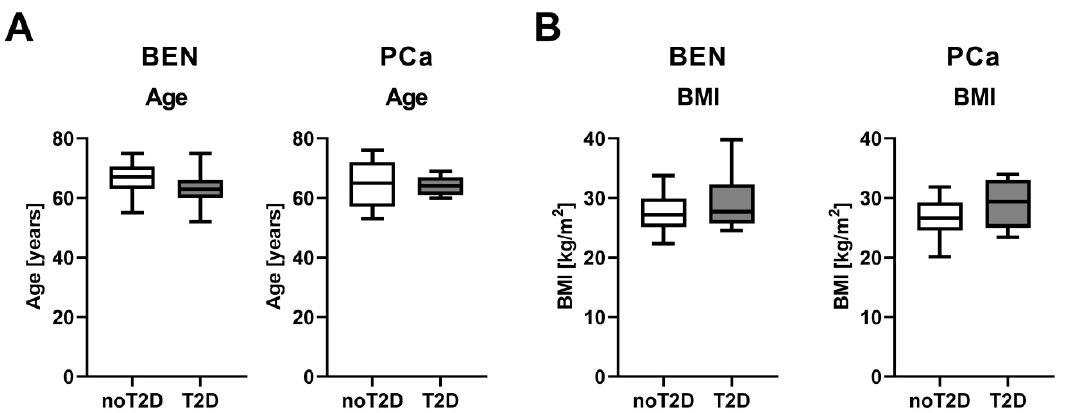
Figure 1. Benign prostate (BEN) (n = 17–17) and prostate cancer (PCa) (n = 11–11) tissues of PCa patients with (T2D) and patients without (noT2D) type 2 diabetes were studied. Age ( A ) and BMI ( B ) data are shown as Tukey box plots. Statistical significance was calculated using Mann–Whitney tests and considered as p < 0.05. No statistical significant differences were found. Table 1. Most patients with T2D were treated with antidiabetic medications. Numbers (nr) denote the number of patients, who received the respective treatment. T2D T2D Patients with T2D Patients with Therapy BEN Samples PCa Samples Insulin 2